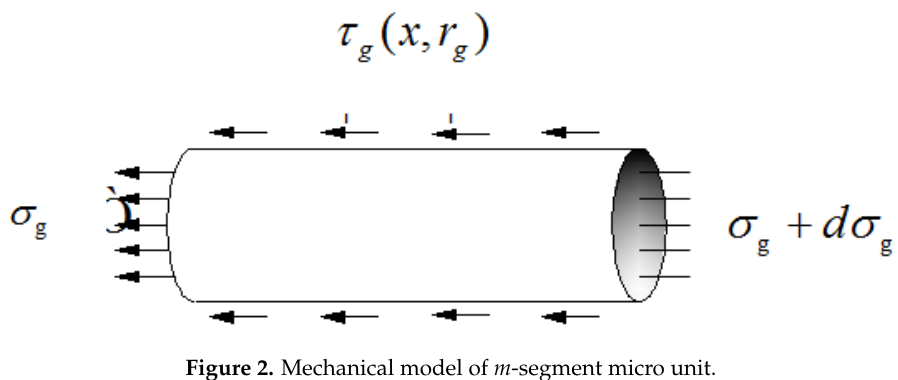
Figure 2. Mechanical model of m -segment micro unit.